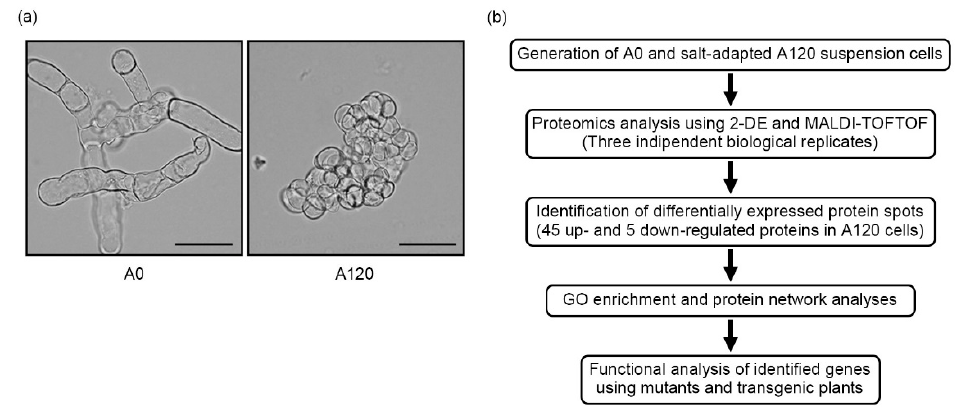
Figure 1. Characterization of Arabidopsis salt-adapted cells. ( a ) The morphological phenotype of control suspension cells (A0) grown in normal MS medium and salt-adapted cells (A120) grown in high salt MS medium with 120 mM NaCl. The photograph was taken using a microscope after 2 weeks of subculture. Scale bars indicate 50 μ m. ( b ) Experimental scheme of proteomic and functional